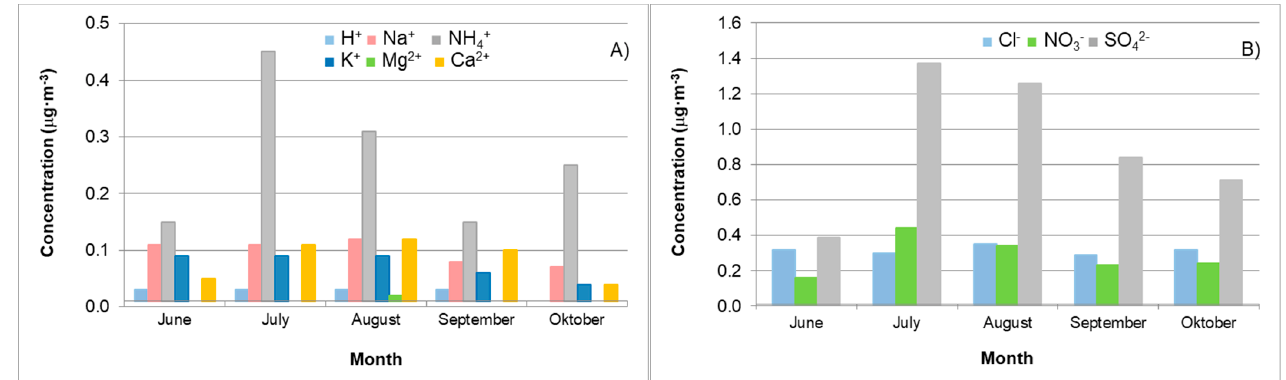
Figure 4. Variability of the cations ( A ) and anions ( B ) average monthly concentrations in atmos- pheric aerosol in the air at the Bolshiye Koty research station in 2020, μ g/m 3 . aerosol in the air at the Bolshiye Koty research station in 2020, µ g/m 3 The main ions in the aerosol composition were NH 4+ , Cl − and SO 42 − . Their dynamics